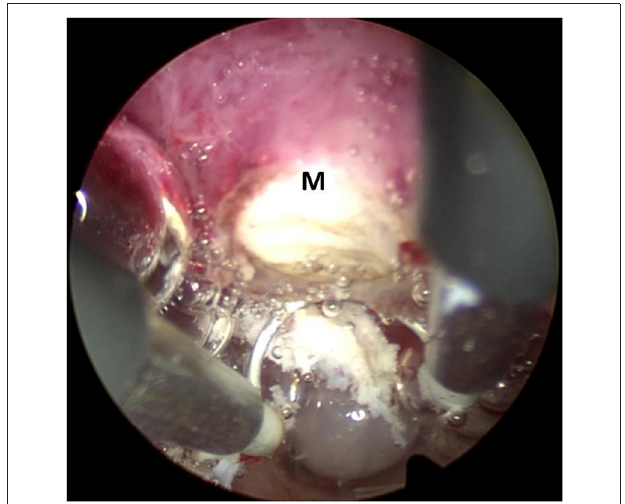
FIGURE 2 | Classical technique of resectoscopic slicing. The bipolar loop was carried beyond the fibroid and begun from the top of the fibroid with the progression in a uniform way toward the base. M: submucous fibroid.